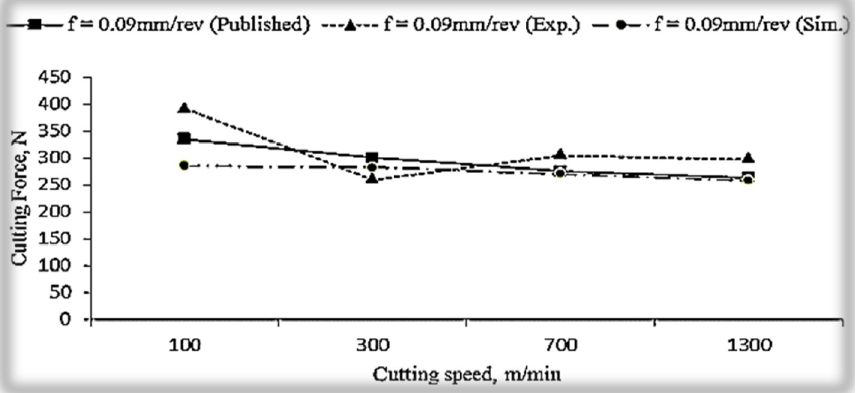
FIGURE 11. COMPARISON OF EXPERIMENTAL AND SIMULATED CUTTING FORCE, FC WITH THE PUBLISHED RESULTS AT THE FEED RATE, F =